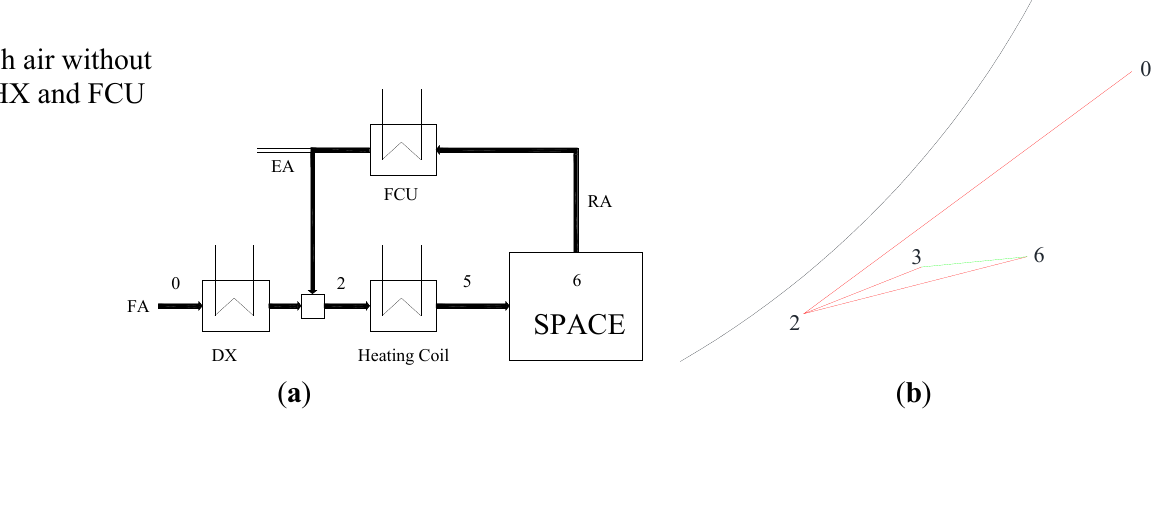
Figure 1. ( a ) The schematic diagram of the fresh air without HPHX and FCU; ( b ) The air treatment processes of the fresh air without HPHX and FCU in a psychrometric